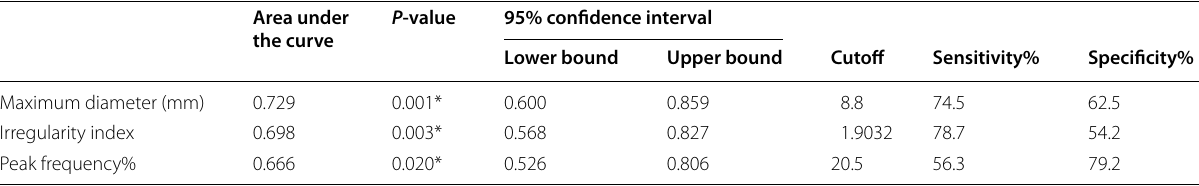
Table 3 Cutoff levels of size and irregularity index